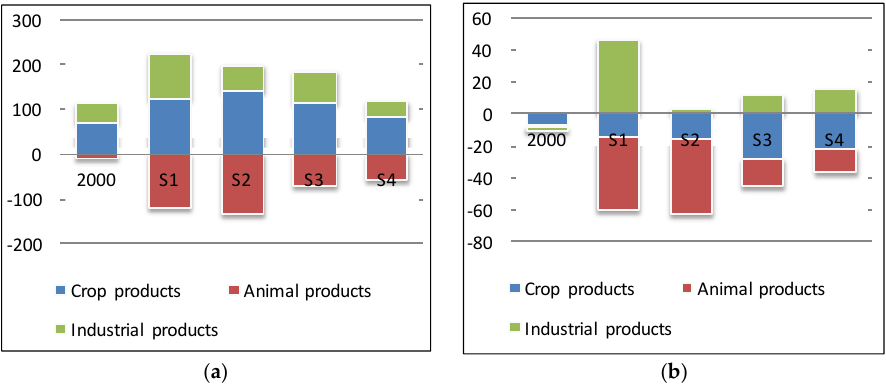
Figure 7. Net virtual water import by ( a ) Western Europe (WEU) and ( b ) Eastern Europe (EEU) (billion m 3 /year), specified by commodity group. Positive values represent net virtual water import; negative values represent net virtual water export.